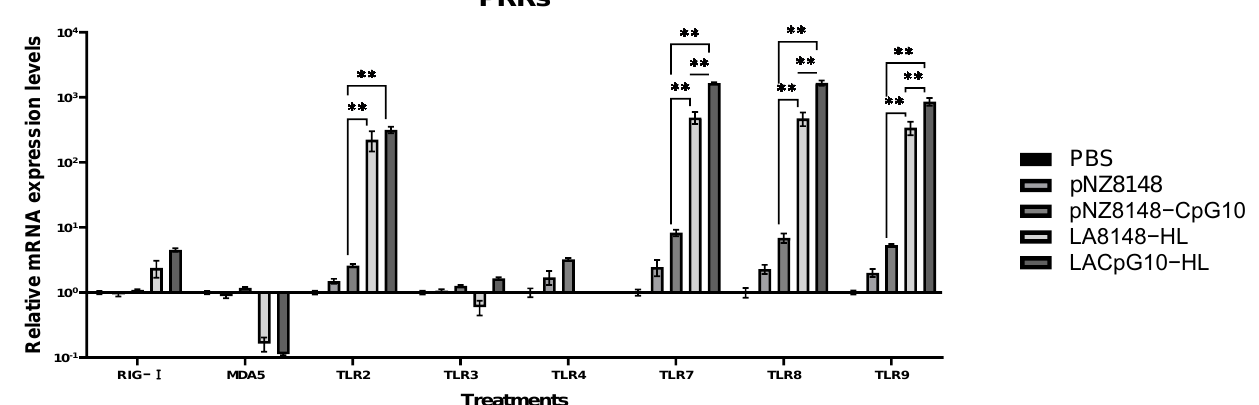
Figure 2. LACpG10-HL effectively motivates the pattern reignition receptors (PRRs). IPEC-J2 cells were respectively treated with PBS, pNZ8148, pNZ8148-CpG10, LA8148-HL, and LACpG10-HL for 30 h. Afterward, the cells were collected for qRT-PCR. The relative mRNA expression levels of PRRs were detected to show how LACpG10-HL initiated the sensors for invading pathogens. Columns represent the means of 3 repeats for each treatment. Significant differences between different treatments were indicated by “**” (** p <